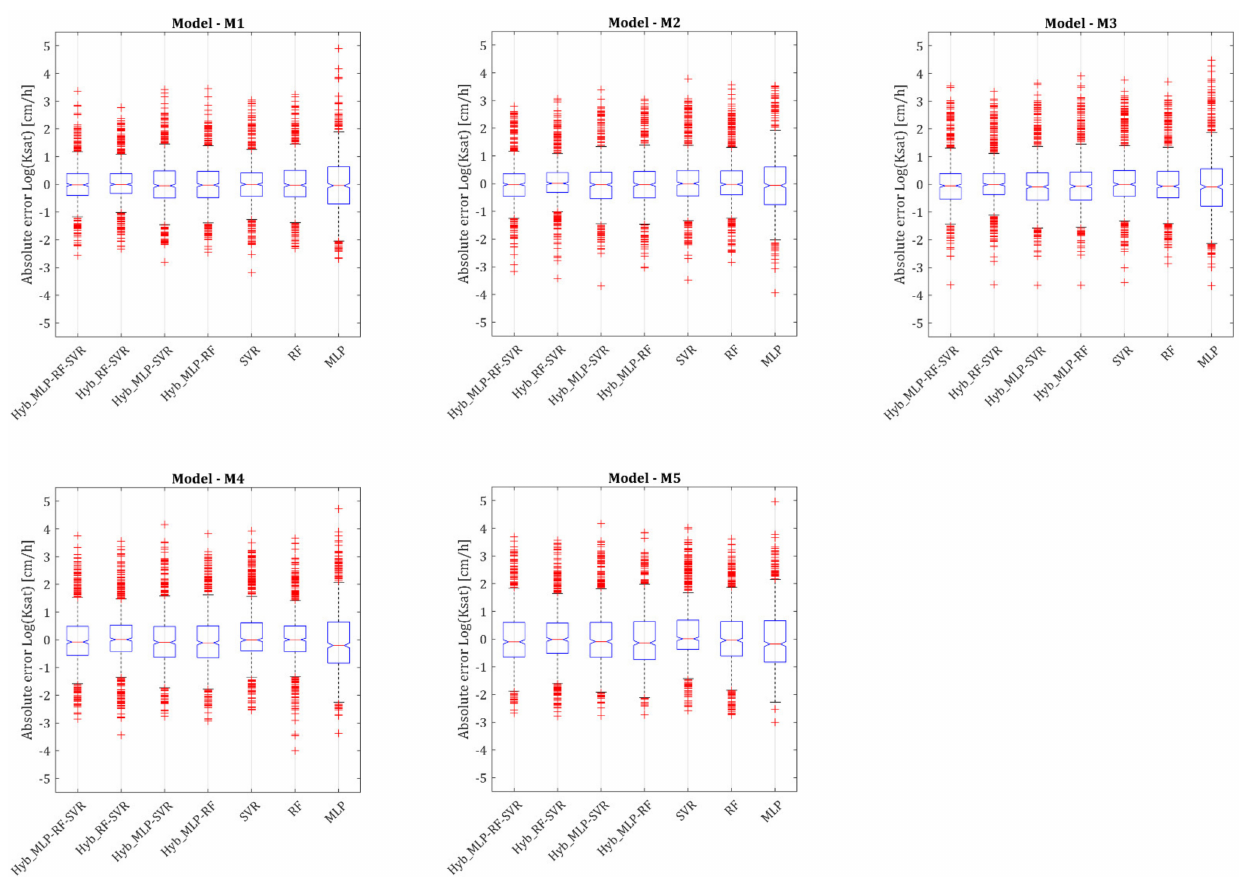
Figure 8. Box plots of the absolute errors in all models and